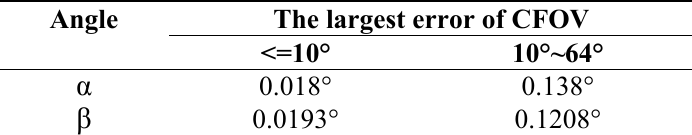
Table 4. The max error in Field of